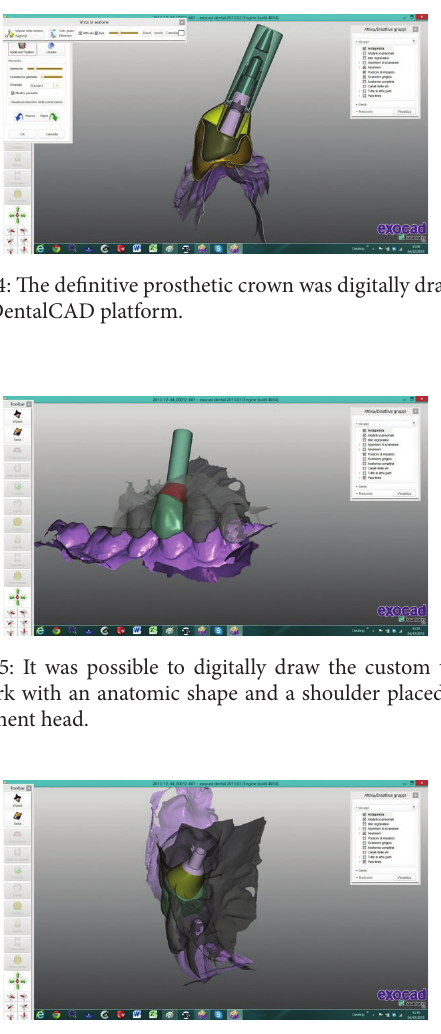
Figure 16: The custom titanium framework with an anatomic shape and a shoulder placed around the abutment head was hidden by the feldspathic porcelain for aesthetics and definitive shape.